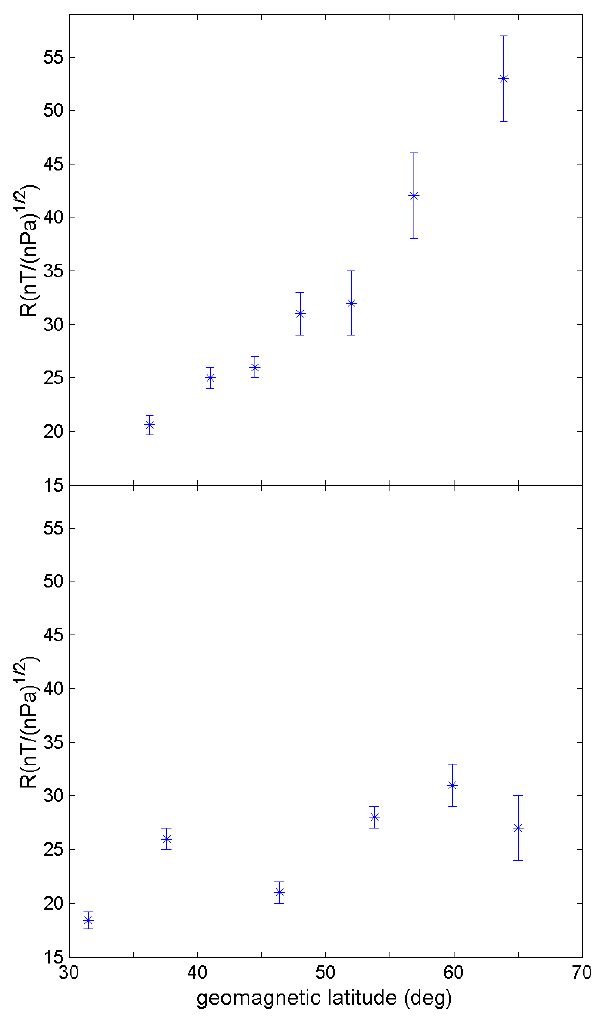
Fig. 8. The ground response R versus the geomagnetic latitude of the stations for the European array (upper panel) and the Asiatic array (lower panel).